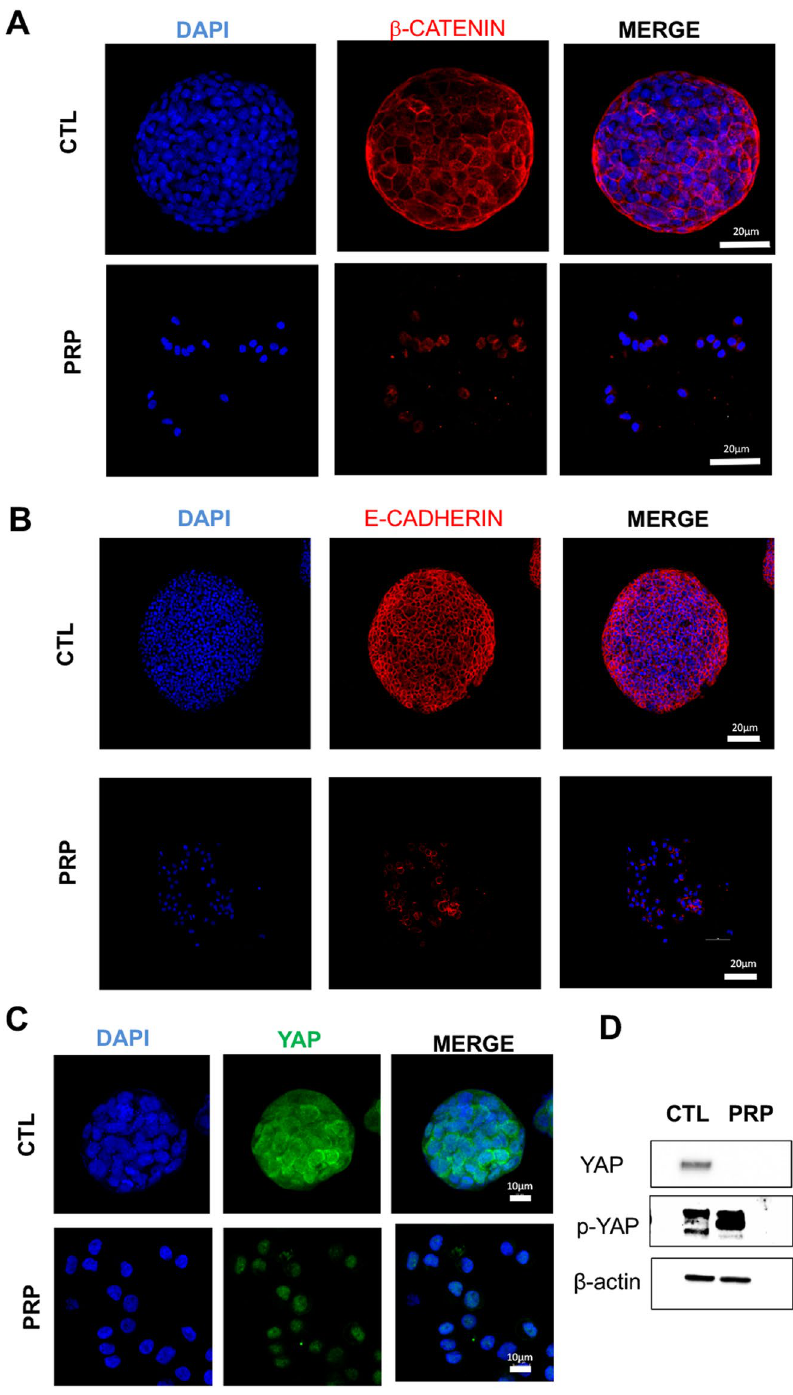
Figure 6. Representative confocal images of tumorigenic proteins in PRP treated pancreatic CSCs versus non- treated CSCs. ( A ) Treatment with PRP maintain membrane-associated β -catenin without nuclear translocation in pancreatic CSCs. ( B ) PRP treatment increased membrane-associated E-cadherin. Cell surface β -catenin and E-cadherin expression was detected in red and nuclei were counterstained with DAPI (blue). Scale bar represents 20 μ m. ( C ) PRP treatment decreased the protein expression of YAP in BxPC3 CSCs. YAP expression appears green and nuclei stained with DAPI (blue). Scale bar represents 10 μ m. ( D ) Western blot analysis of YAP and p-YAP proteins in CSCs treated with PRP versus non-treated. A negative correlation between YAP and p-YAP expression was